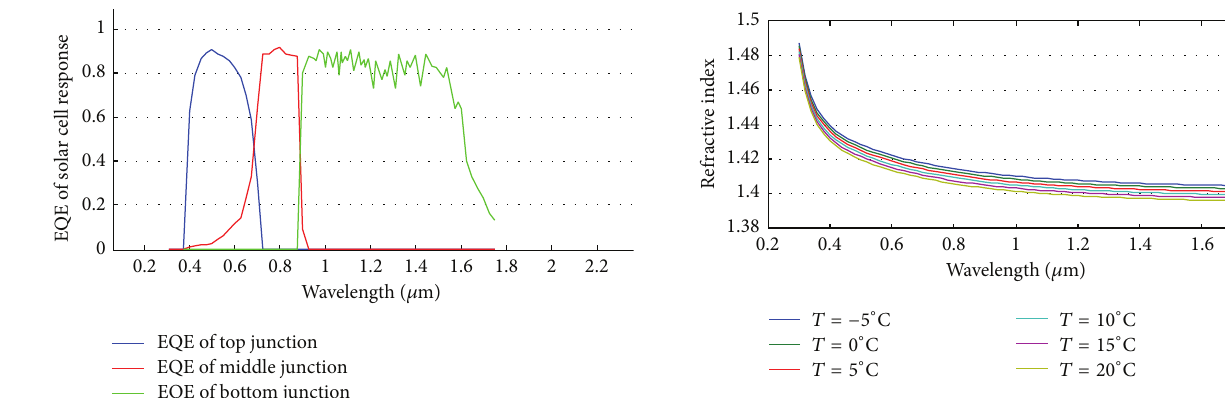
Figure 5: The different external quantum efficiency of triple- junction solar cell.